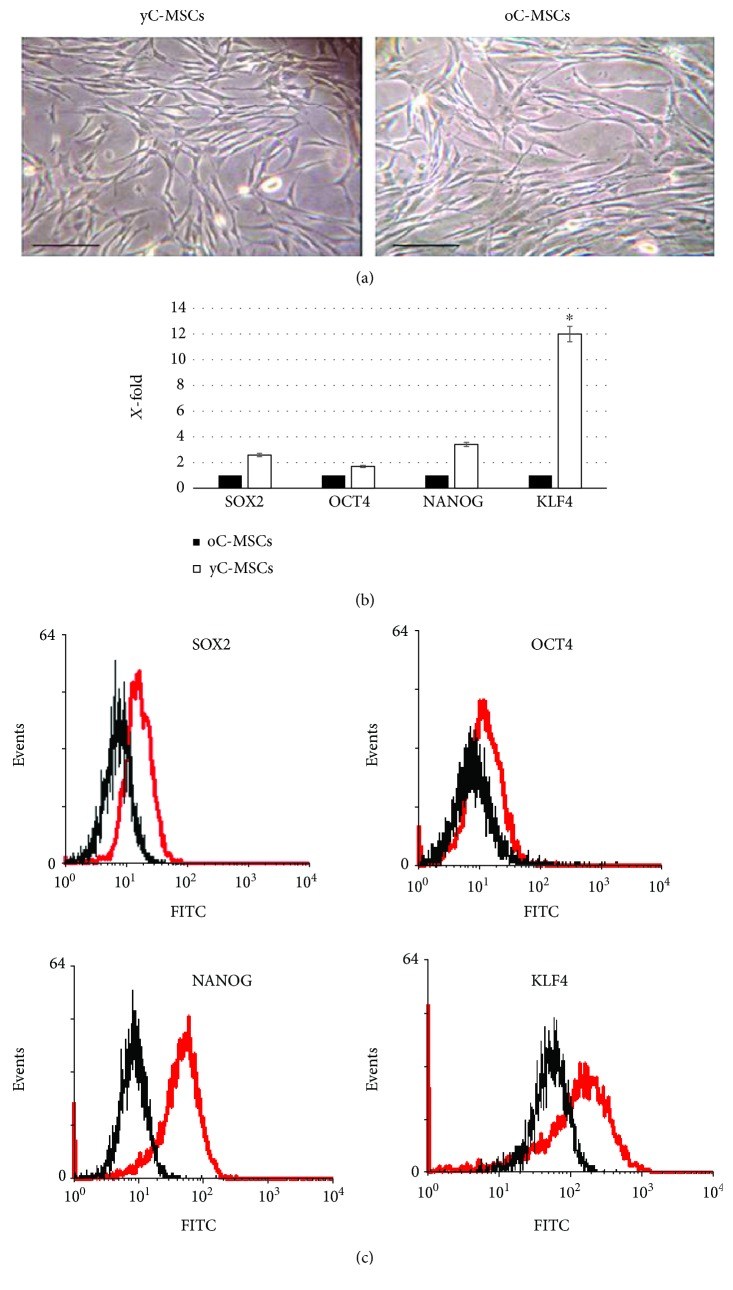
Morphology and expression of genes related to stemness. (a) Phase-contrast images of MSCs derived from the cervixes of younger (yC-MSCs, left) and older patients (oC-MSCs, right) after 14 days of culture. Scale bar, 100 μm. The expression of selected markers related to self-renewal and differentiation potential (OCT4, SOX2, NANOG, and KLF4) was evaluated by RT-PCR (b) and cytofluorimetry (c). (b) Levels of expression detected in yC-MSCs are referred to as X-fold with respect to oC-MSCs (expressed as equal to 1). Data are means ± SD from analyses performed on three separate experiments in triplicate. ∗p < 0.05 for yC-MSCs versus oC-MSCs. (c) Representative FACScan analyses of cell-surface antigen expression, as indicated. Black histograms refer to oC-MSCs and red histograms to yC-MSCs.